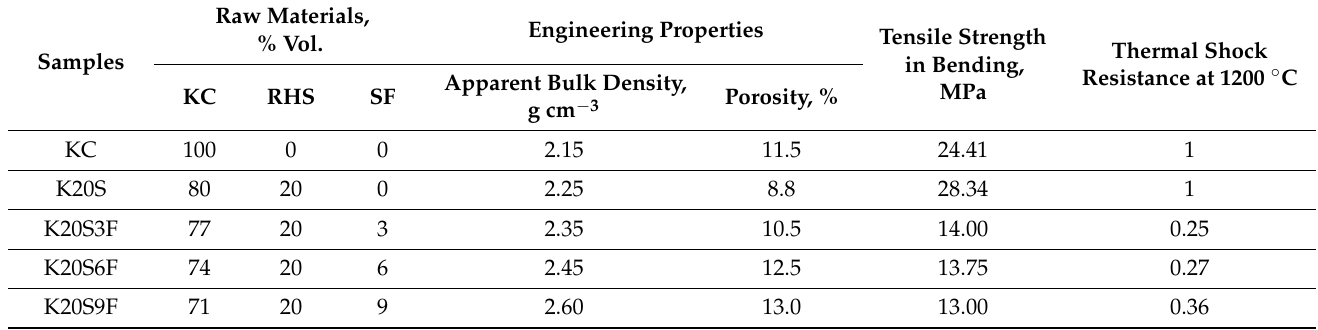
Table 3. Composition and properties of KC/RHS/SF-based refractory. Data from [35]. Raw Materials, % Samples